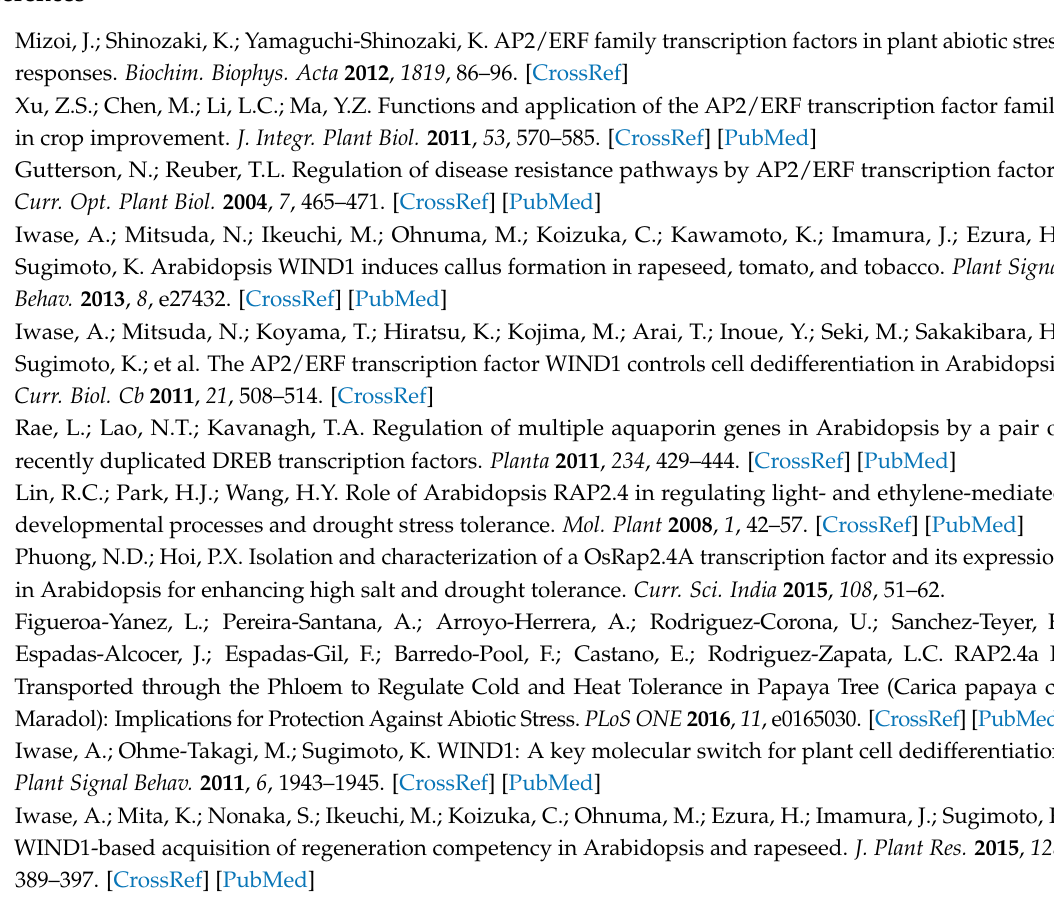
Figure S1: qRT-PCR expression analysis of BrRAP2.4-1, -2, and -3 in different tissues of B. rapa plants. Figures S2–S4: Sequence information on BrRAP2.4-1. Figure S5: DNA and amino acid sequences of BrRAP2.4-2 and BrRAP2.4-3. Figure S6: Representative blots for Figure 5b–c quantification. Figure S7: Pulldown analysis showing that GST:AtRAP2.4 and GST:BrRAP2.4-1 can pulldown AtCUL3 from plants extracts, while GST alone can not. Figure S8: Basic expression analysis of GFP:BrRAP2.4-1 in Arabidopsis. Figure S9: Deletion of the SBC motif in AtRAP2.4 does not significantly alter stability or interaction with AtBPM3. Table S1: List of Primers used in this